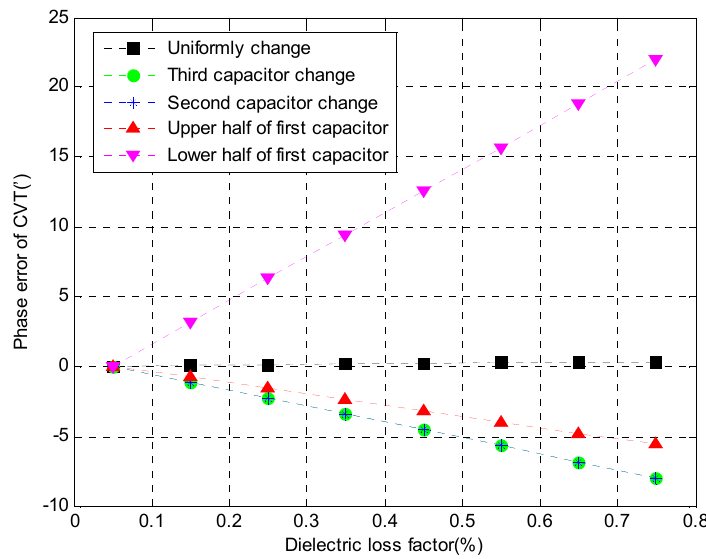
Figure 9. CVT phase error with different dielectric loss factor.